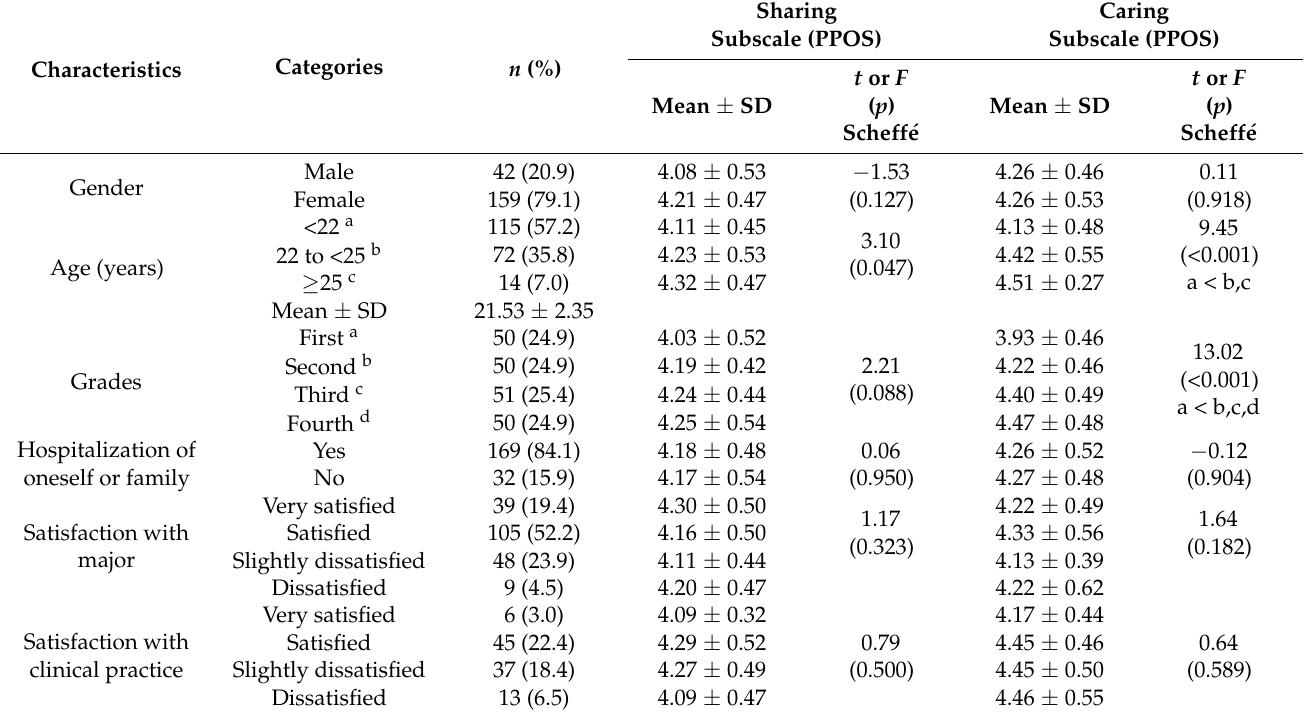
Table 1. Participant Characteristics and Related Differences in Patient-Centeredness as Measured by the Patient–Practitioner Orientation (PPOS) Scale ( n =